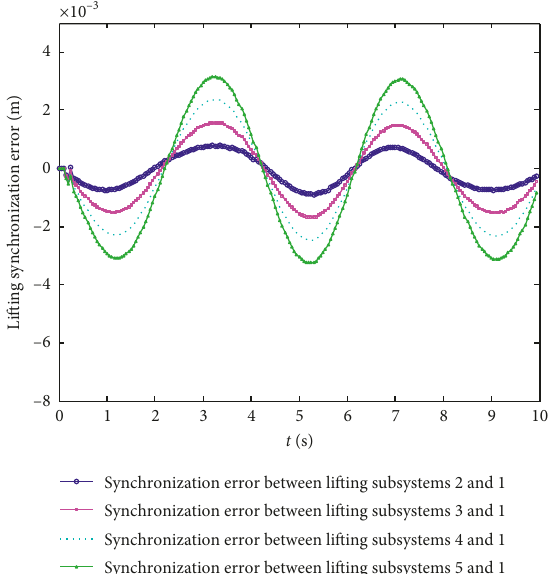
Figure 7: Synchronization errors of the lifting system with pro- posed